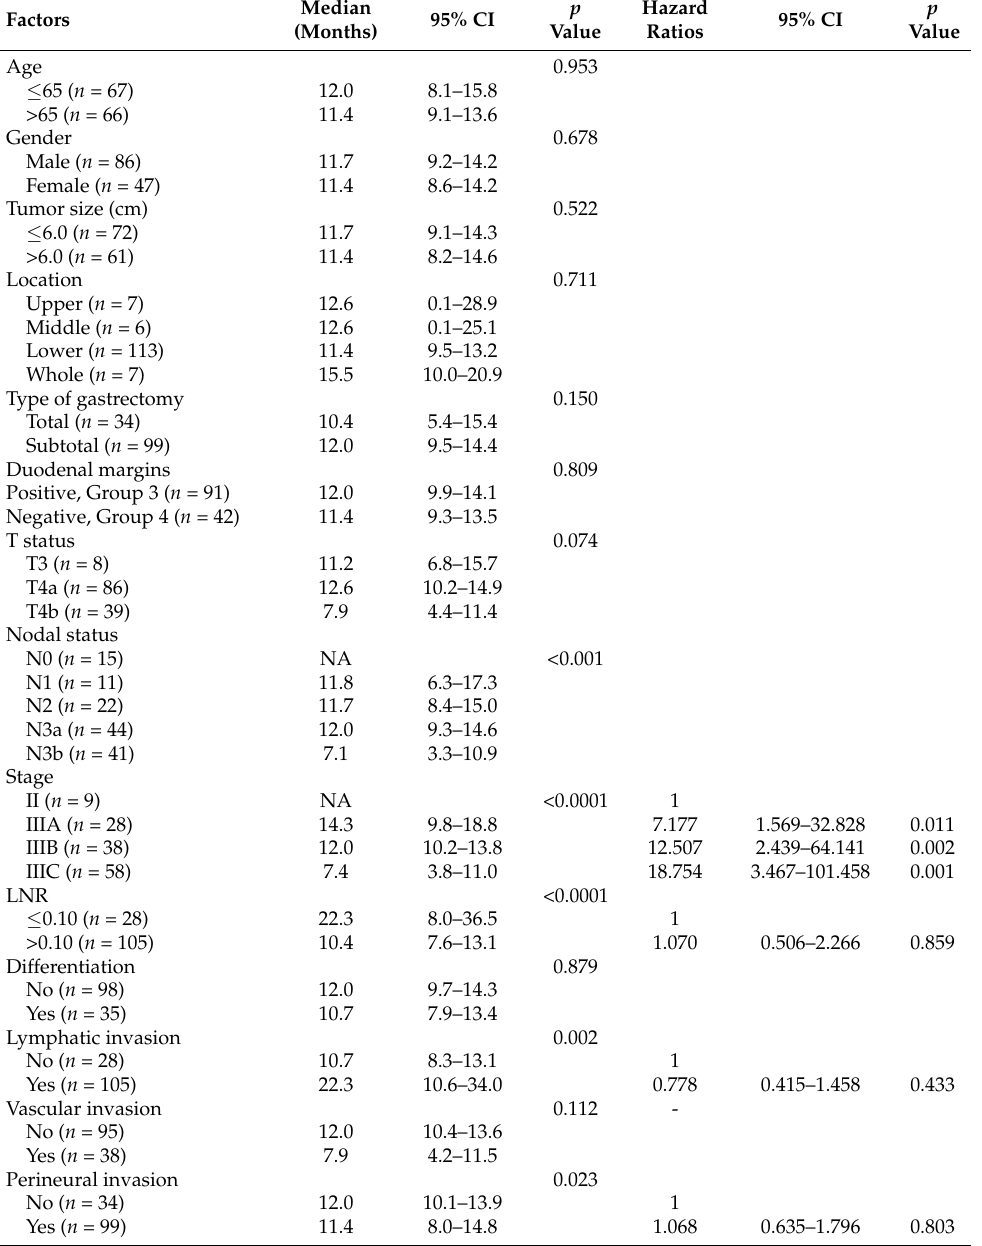
Table 5. Univariate and multivariate analysis of prognostic factors for disease-free survival in group 3 and 4